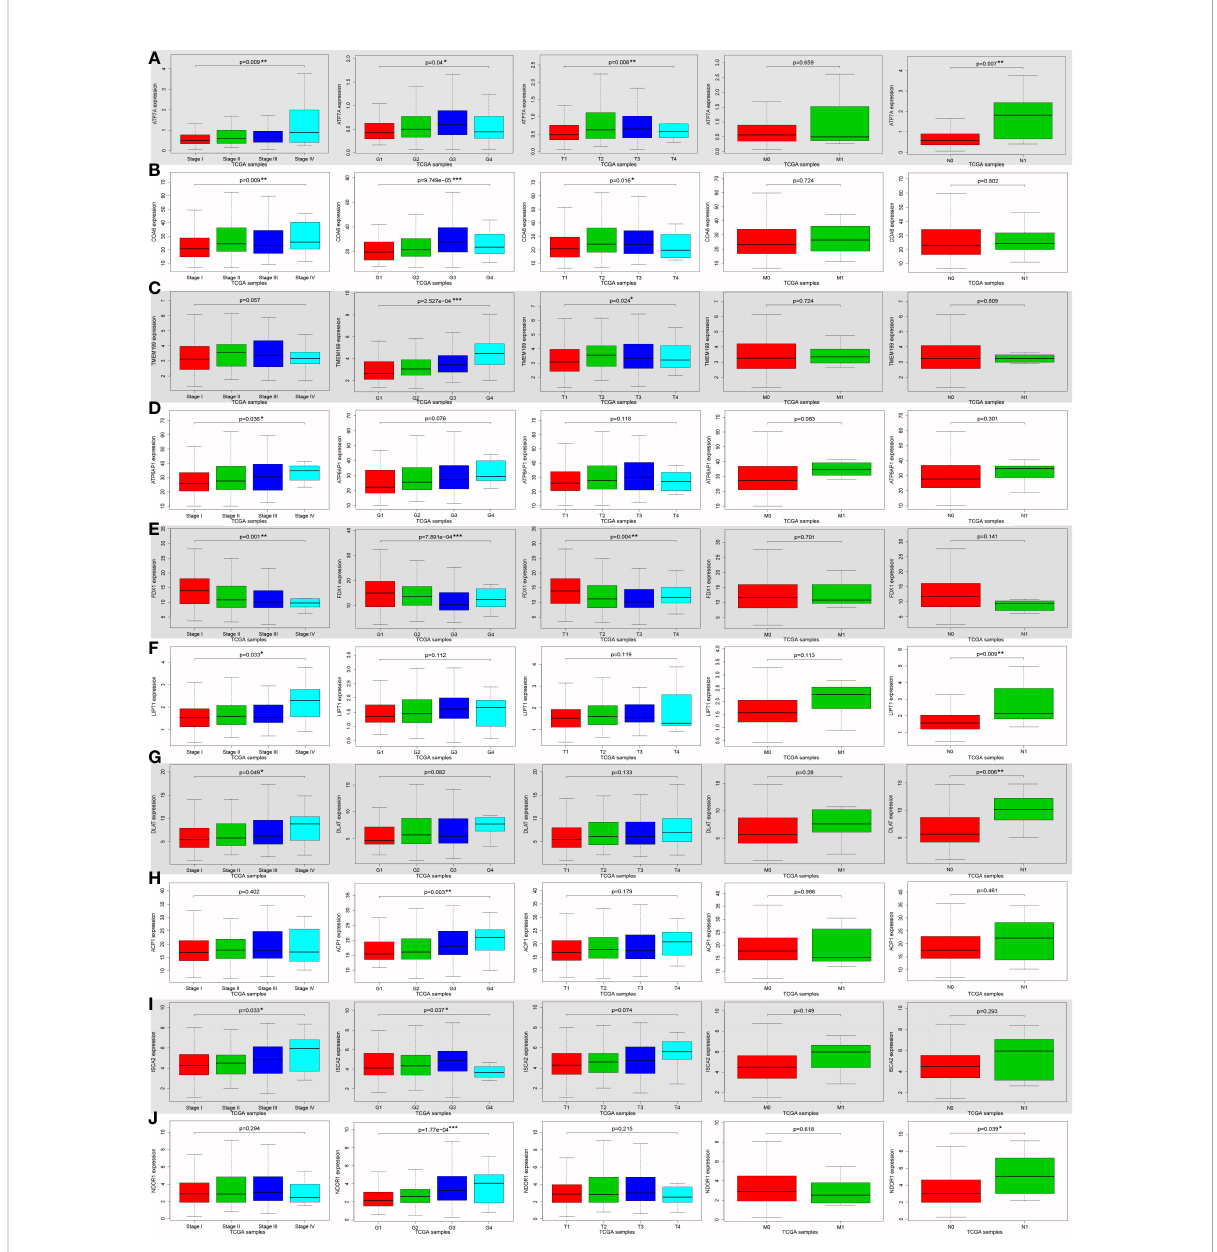
FIGURE 4 The correlation between ten cuproptosis-related gene expression levels and various clinicopathological features in hepatocellular carcinoma (HCC) patients using Wilcoxon signed-rank test or Kruskal-Wallis test from the TCGA database. The correlation between various clinicopathological features and cuproptosis-related genes expression levels in HCCs, including ATP7A (A) , COA6 (B) , TMEM199 (C) , ATP6AP1 (D) , FDX1 (E) , LIPT1 (F) , DLAT (G) , ACP1 (H) , ISCA2 (I) , and NDOR1 (J) . (ACP1, acid phosphatase 1; ATP6AP1, ATPase H+ transporting accessory protein 1; ATP7A, copper-transporting p-type adenosine triphosphatase 1; COA6, cytochrome c oxidase assembly factor 6; DLAT, dihydrolipoamide S-acetyltransferase; FDX1, ferredoxin 1; G, histologic grade; HCC, hepatocellular carcinoma; ISCA2, iron-sulfur cluster assembly 2; LIPT1, lipoyltransferase 1; M, distant metastasis; N, lymph node metastasis; NDOR1, NADPH dependent di fl avin oxidoreductase 1; Stage, clinical stage; T, tumor stage; TCGA, The Cancer Genome Atlas; TMEM199, transmembrane protein 199; * P < 0.05; ** P < 0.01; *** P <